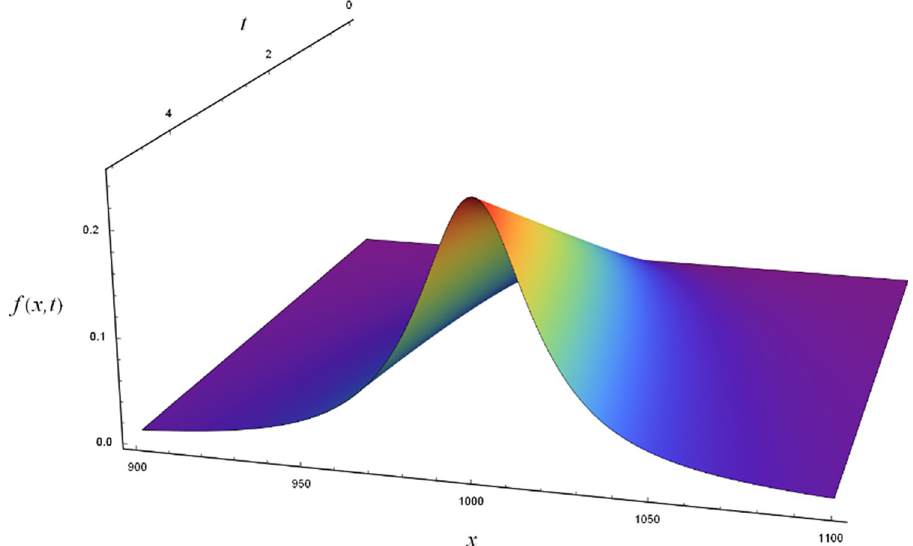
Fig 1. Visualization of Cauchy-type function used throughout this work. The curve depicted was generated with x 0 = 1000, γ = 30, a = b = 0.